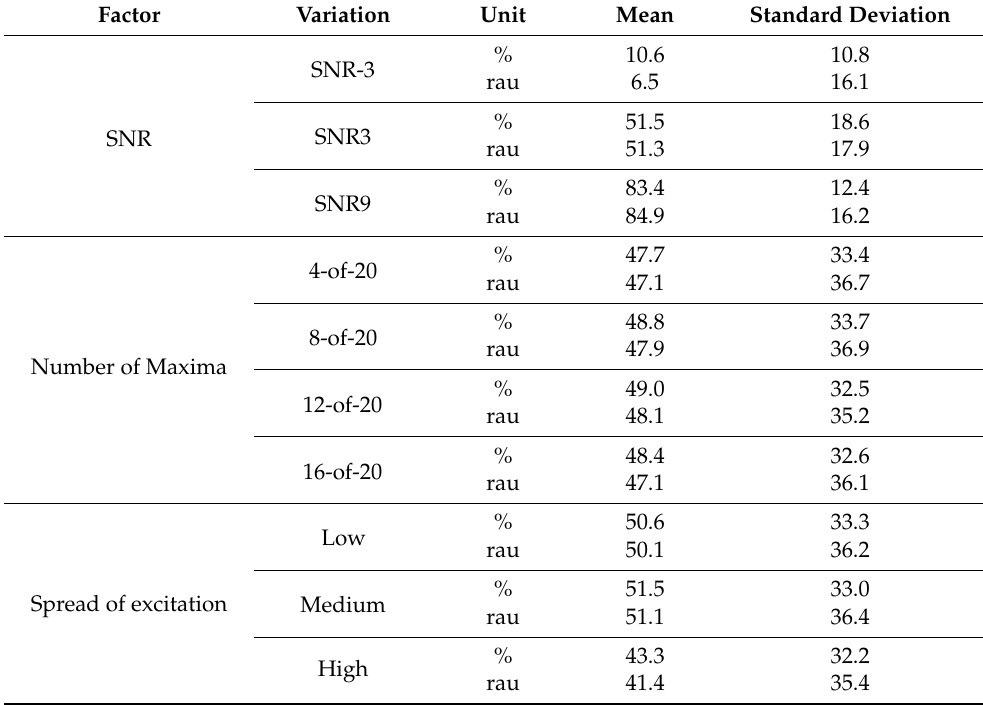
Table 4. Average syllable recognition scores for each factor and variation.